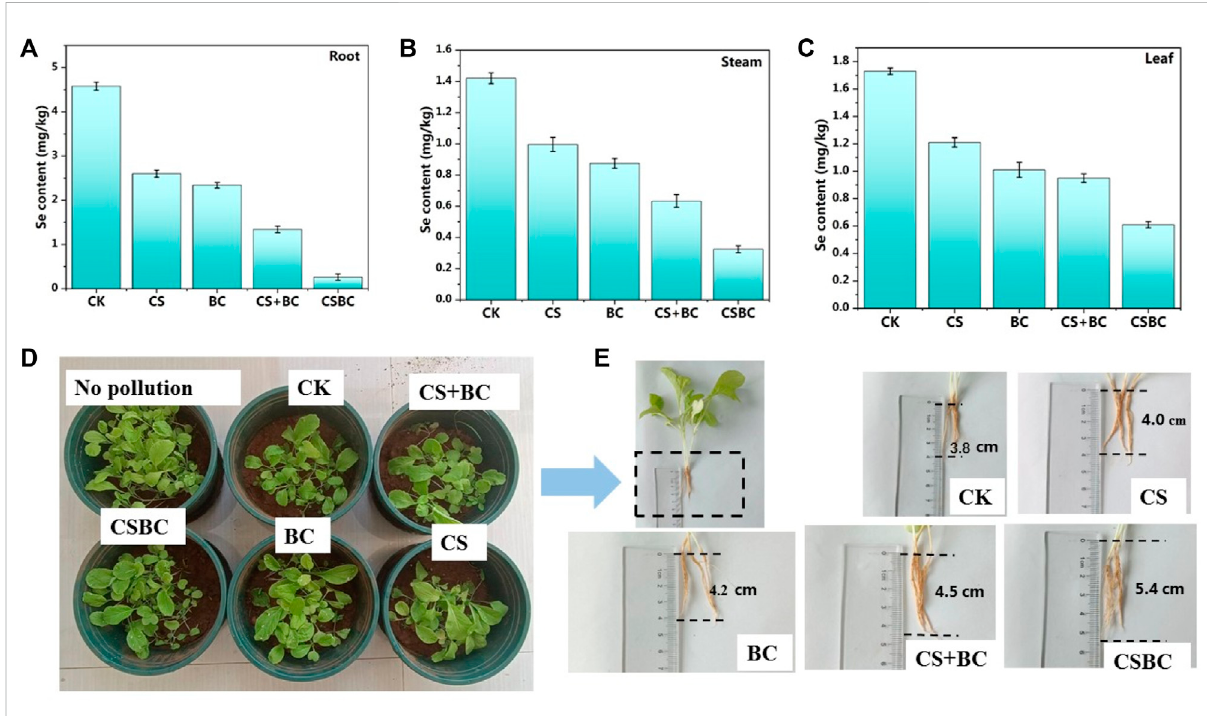
FIGURE 6 Se(IV) content in roots (A) , stems (B), and leaves (C) and growth picture (D) (E) of bok choy under various adsorbent